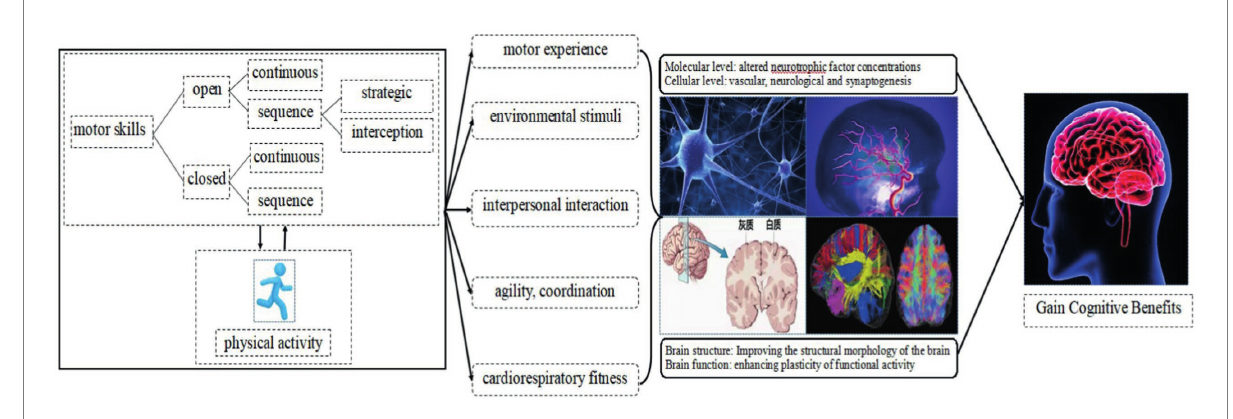
FIGURE 1 Pathways and mechanisms by which motor skills enhance the cognitive benefits of children and